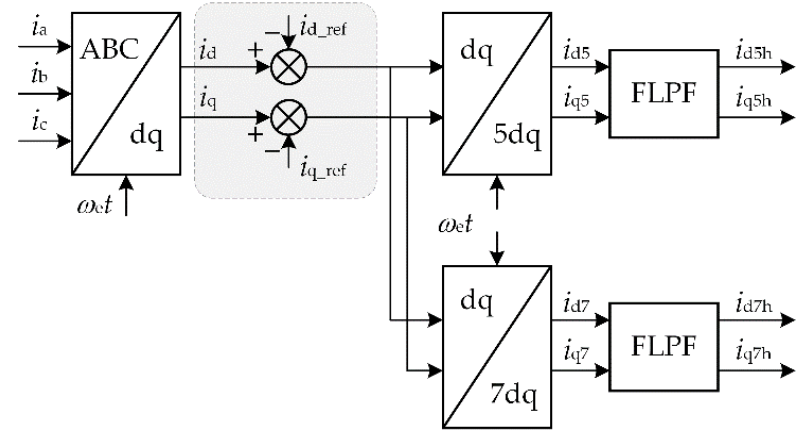
Figure 2. The block diagram of proposed method of current harmonic extraction. The current harmonic controller is the key to make the current harmonic components follow the current harmonic reference value. Traditional PI-based current harmonic con- troller generally makes the difference between the extracted 5th and 7th current harmonic components and the reference value 0, and then inputs the obtained values to the PI con- trollers to generate the harmonic compensation voltages. The harmonic compensation voltages are injected into the dq axis voltages through the inverse MSTFT. The block dia- gram of this method is shown in Figure 3. i d5h_ref , i q5h_ref , i d7h_ref and i q7h_ref represent the reference value of the 5th and 7th current harmonic dq axis components,